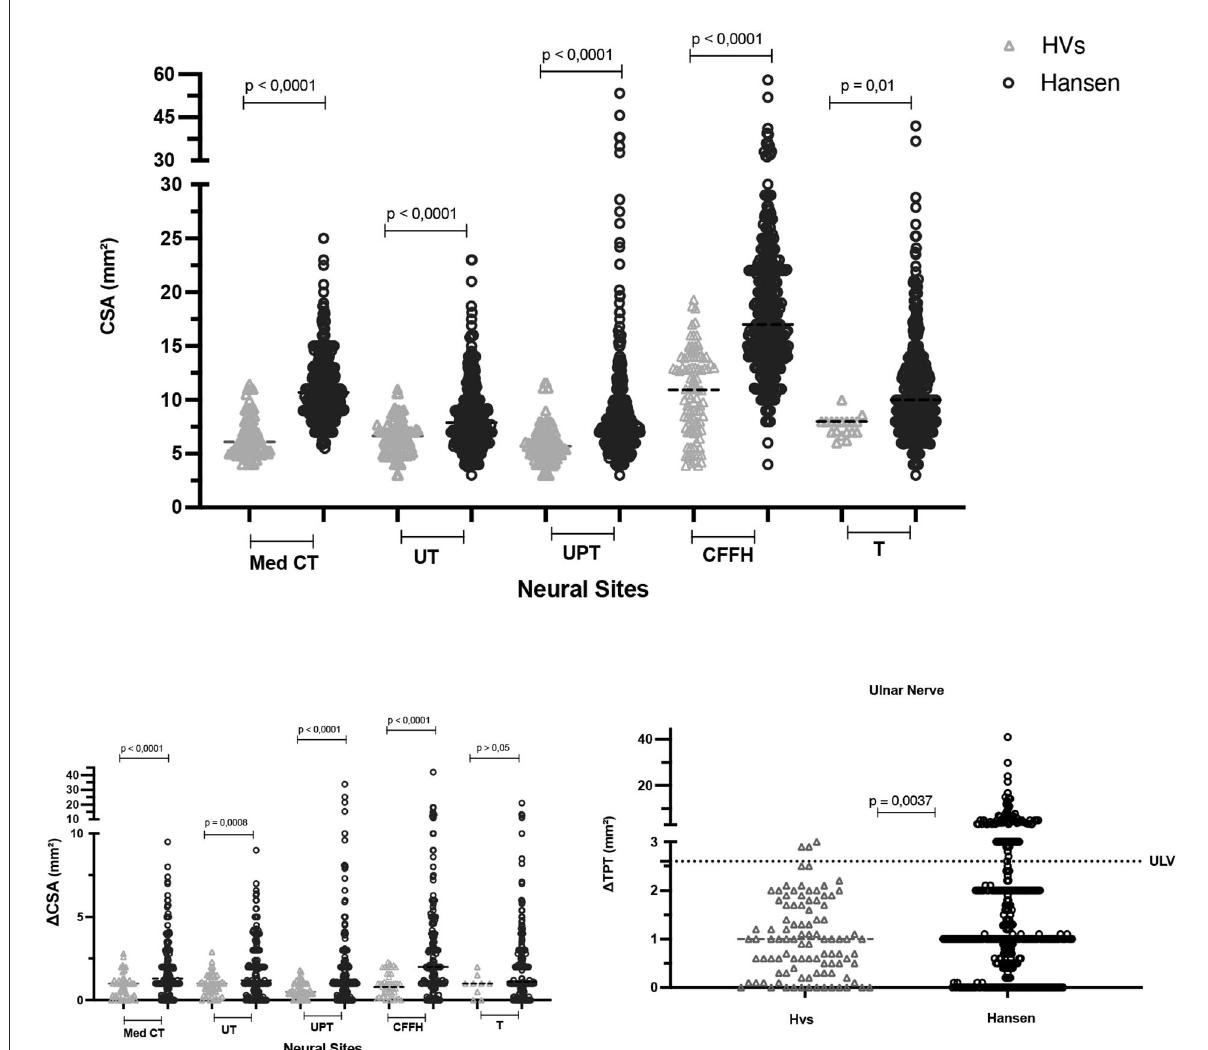
FIGURE5 Comparative analysis of peripheral nerve CSA, 1 CSA (mm 2 ), and 1 TPT (mm 2 ) values between healthy individuals and patients with Hansen’s disease aged 15–60 years. CSA, cross-sectional area; Med CT, median carpal tunnel; Med FA, median forearm; UT, cubital ulnar tunnel; UPT, cubital ulnar pretunnel; CFFH, common fibular in the fibula head; CFpFH, common fibular proximal fibular head; T, tibial; 1 CSA, difference between the right and the left nerve at the same site of assessment; 1 TPT, difference between the same nerve at different sites of assessment; HVs, healthy volunteers; Hansen, patients with Hansen’s